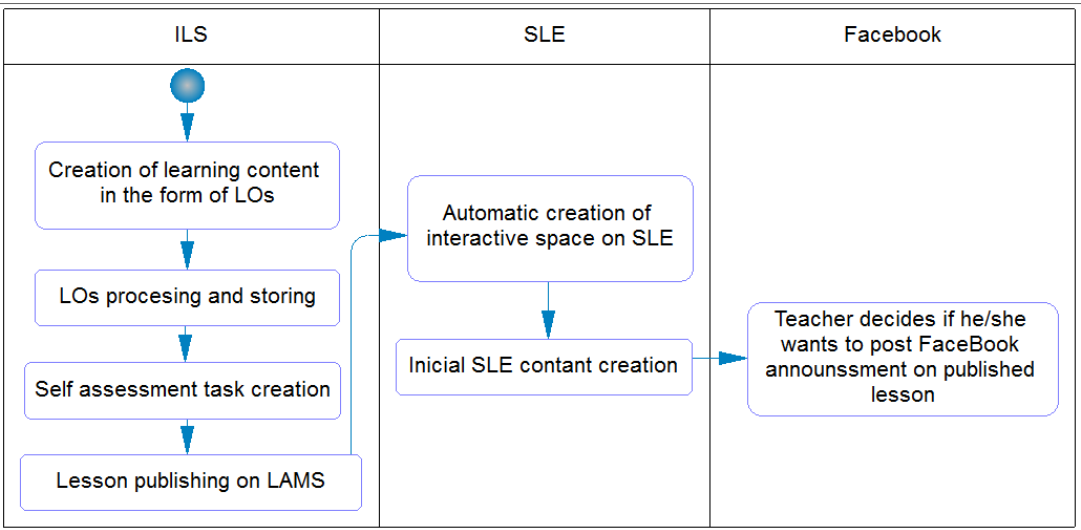
Figure 1 . Model of teaching activities.